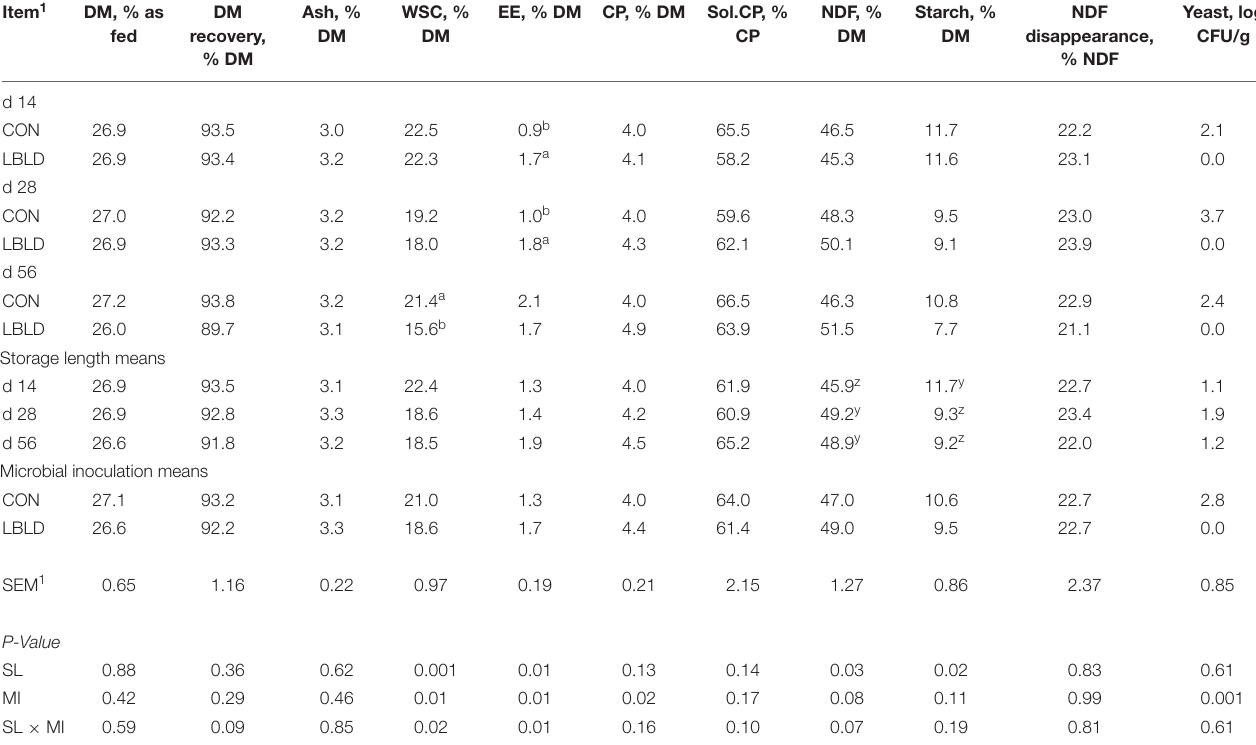
TABLE 7 | Effect of microbial inoculation and storage length on the nutrient composition and yeast counts of whole-plant sweet sorghum silage in experiment